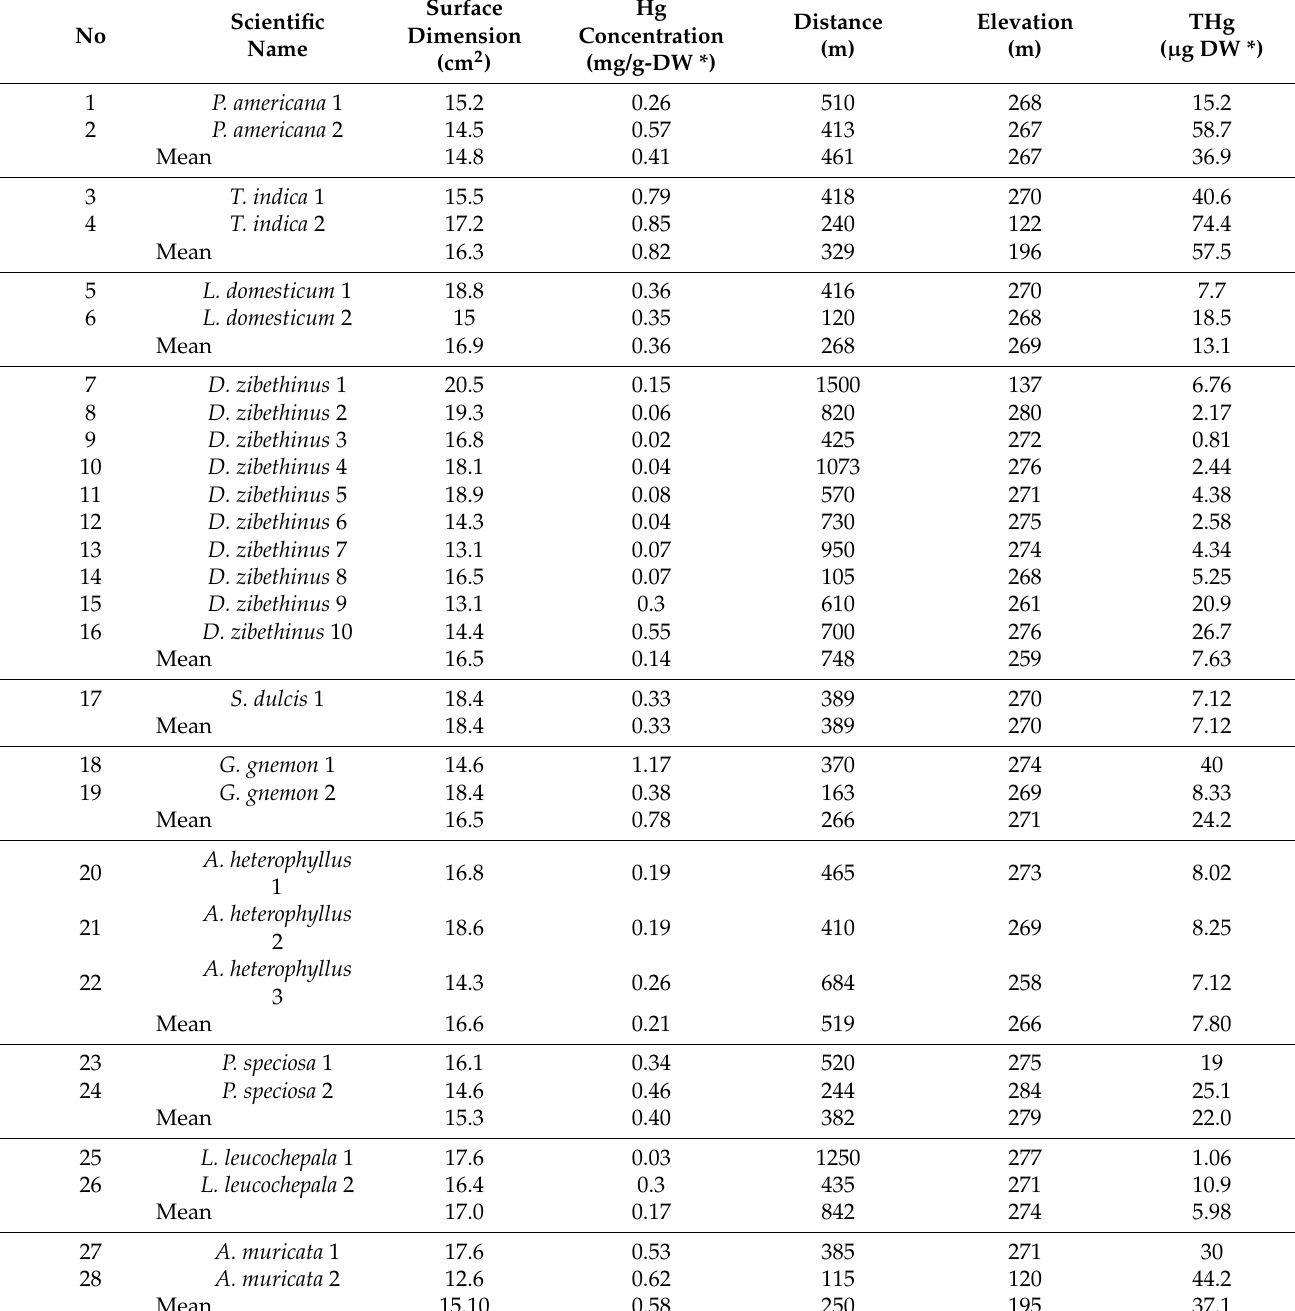
Table 1. Mercury and THg concentrations in the tree barks of the MPTS